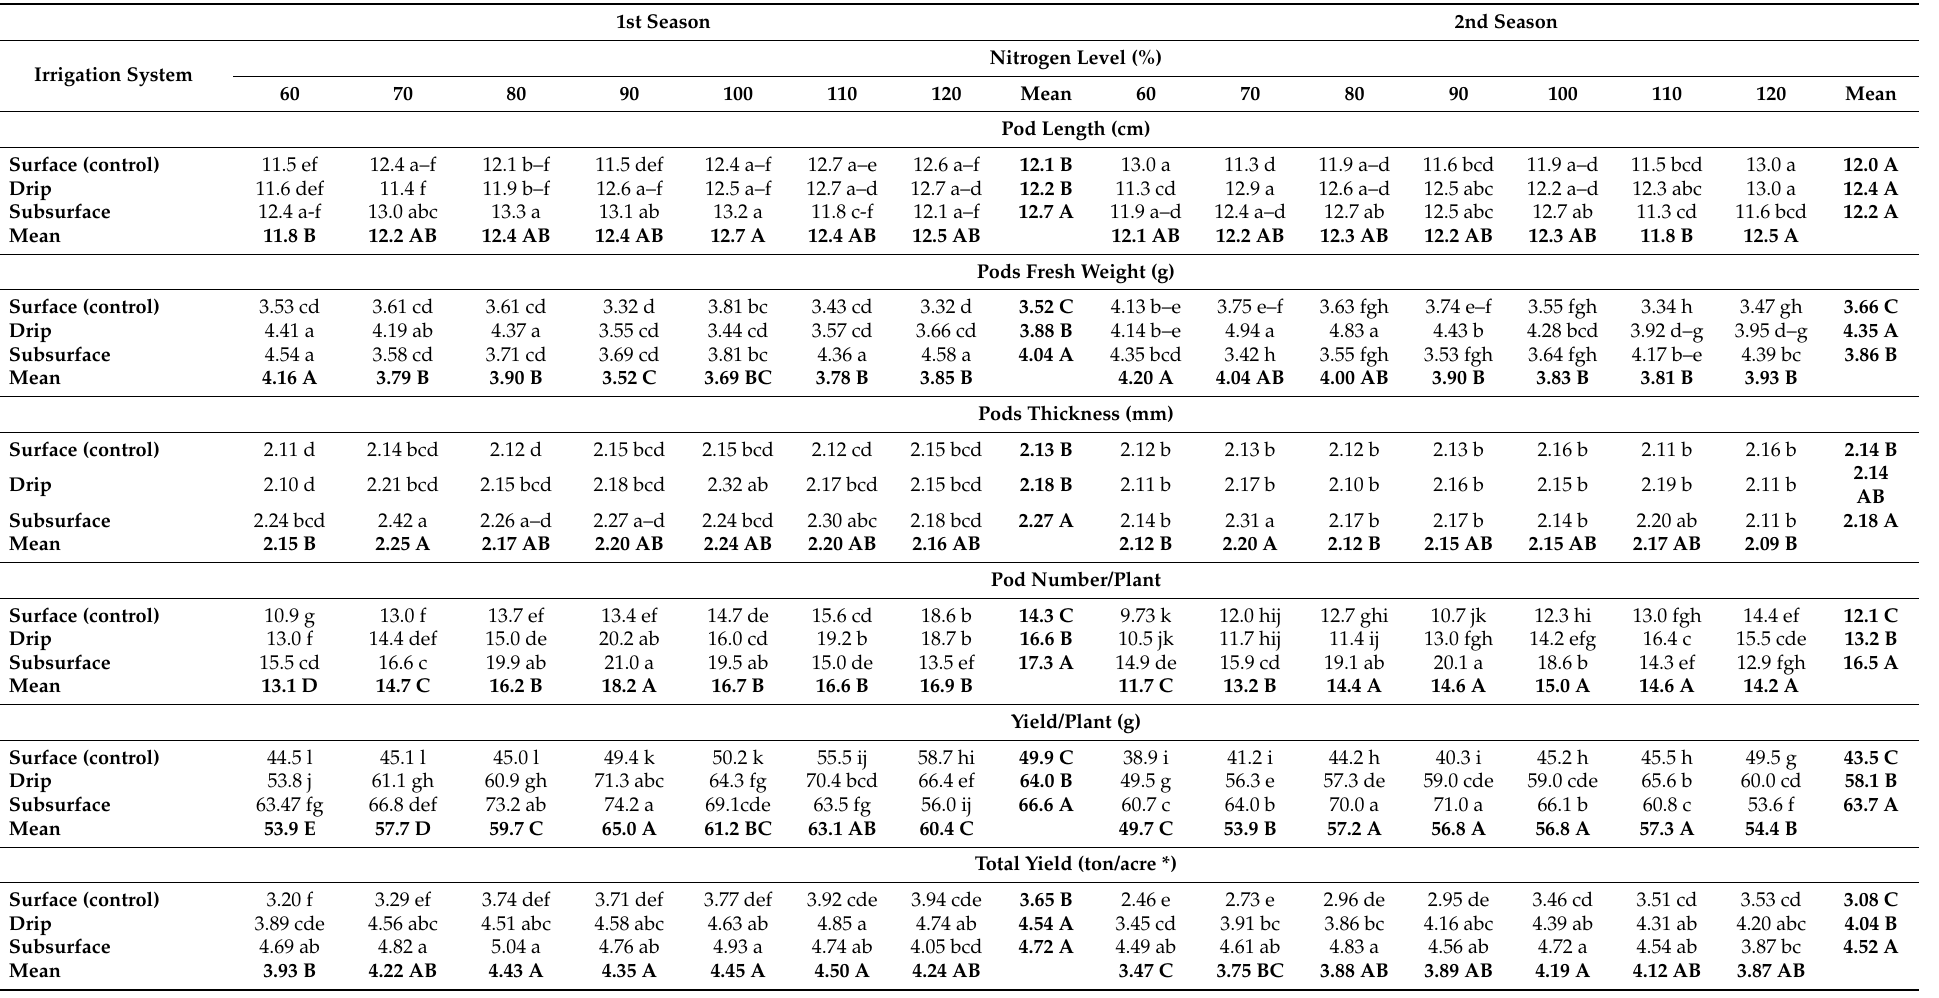
Table 4. Crop measurements’ means at different irrigation systems and nitrogen treatments in seasons 2019 and